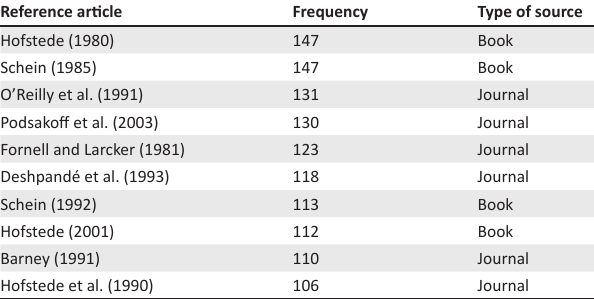
TABLE 8: The top 10 references in this